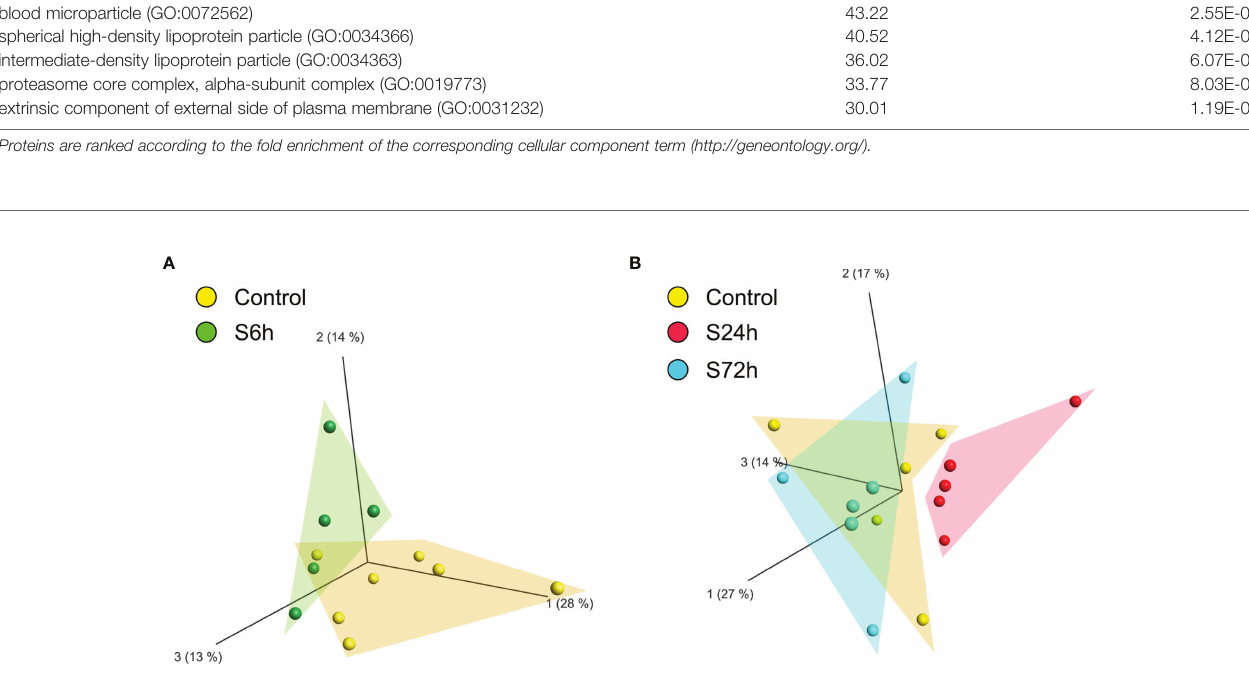
FIGURE 3 | Principal component analysis (PCA) of the proteomic data of circulating EVs. LC/MS produced quantitative proteomic data (protein abundances) were quantile normalized, log2-transformed, and used by Qlucore software for creating the PCA plots. (A) Control and 6 h post-surgery (S6h) experimental group form individual clusters. (B) Control and S24h groups are completely separated whereas the S72h group overlaps with the control